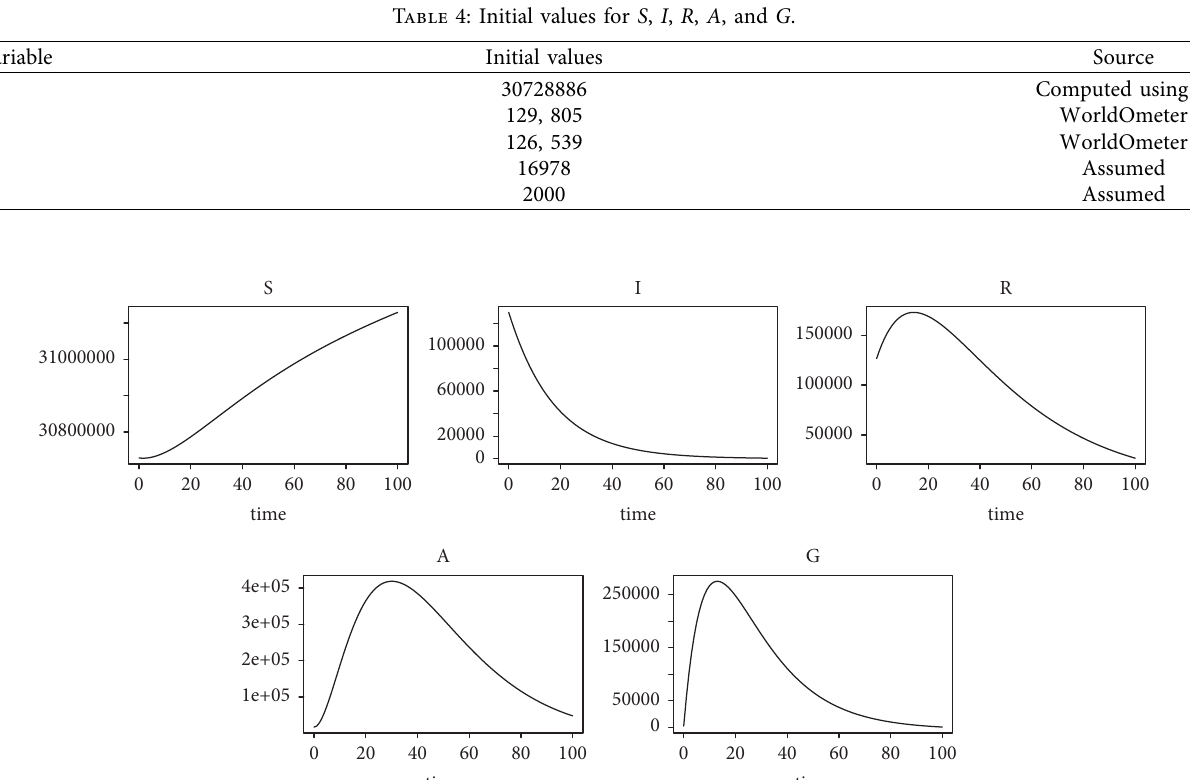
Figure 2: Time series of the susceptible class ( S ), infectious class ( I ), recovered class ( R ), demand for FPPES ( A ), and government policy regulation ( G